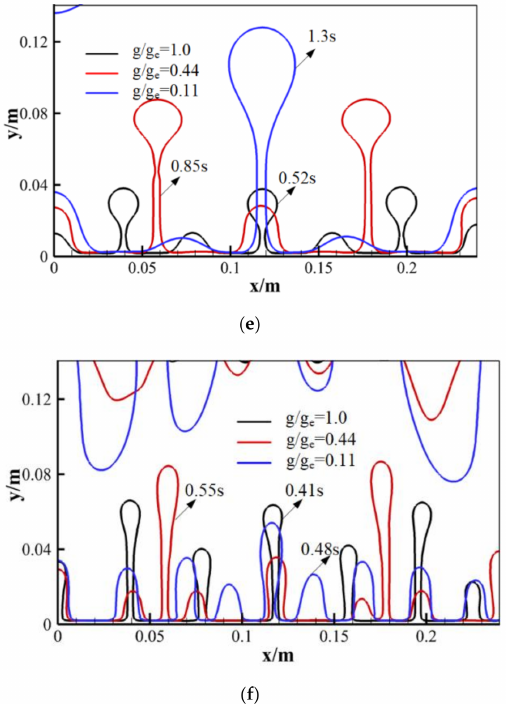
Figure 5. Phase interface evolution when applying a magnetic field. ( a ) H 0 = 0 kA/m, ( b ) H 0 = 5 kA/m, ( c ) H 0 = 10 kA/m, ( d ) H 0 = 15 kA/m, ( e ) H 0 = 20 kA/m, and ( f ) H 0 = 30